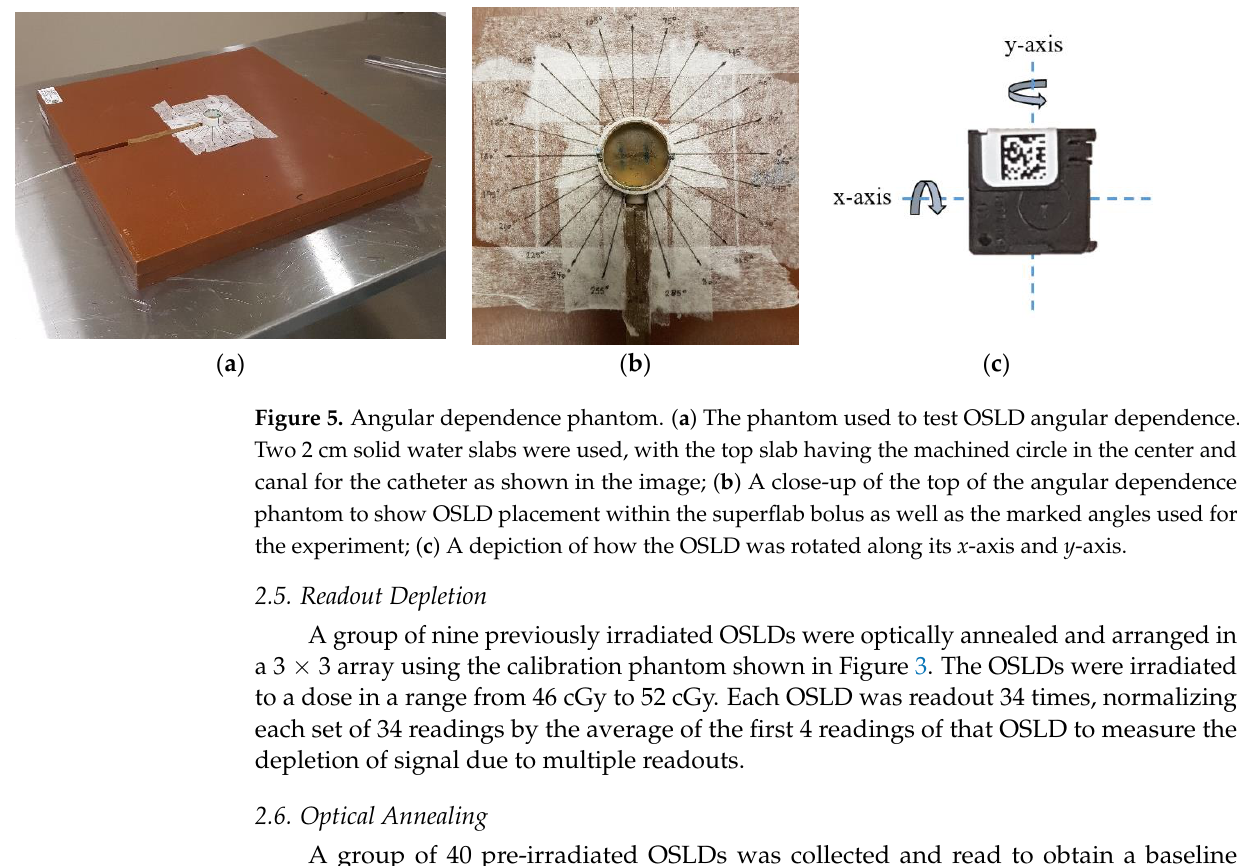
6 Figure 4. Dose rate dependence phantom. The phantom used to test OSLD dependence on dose rate. An additional 8 cm of solid water was added to the middle of the phantom to provide a total source- to-OSLD distance of 12 cm, as shown in this image. 2.4. Angular Dependence A new phantom was designed to test the angular dependence of OSLDs, and the phantom is shown in Figure 5. The top slab of solid water was 1 cm thick and had a ma-